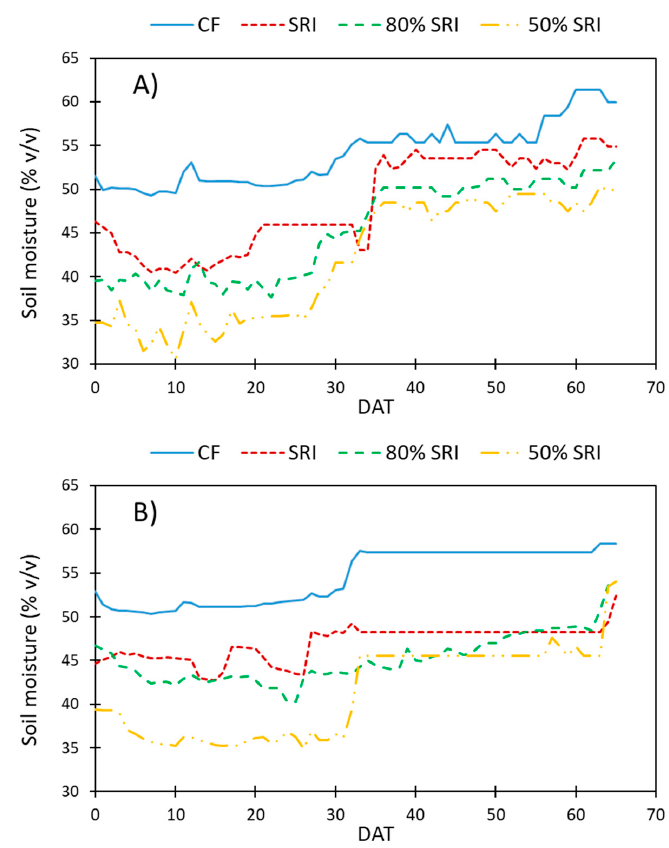
Figure 5. Daily soil moisture at 30 cm depth during the ( A ) dry season (October 2012 to January 2013) and ( B ) wet season (February 2013 to June 2013). CF is continuous flooding, SRI is system of rice intensification, 80% SRI and 50% SRI refers to 80% and 50% of the SRI ponding depth, respectively DAT is days after transplanting.